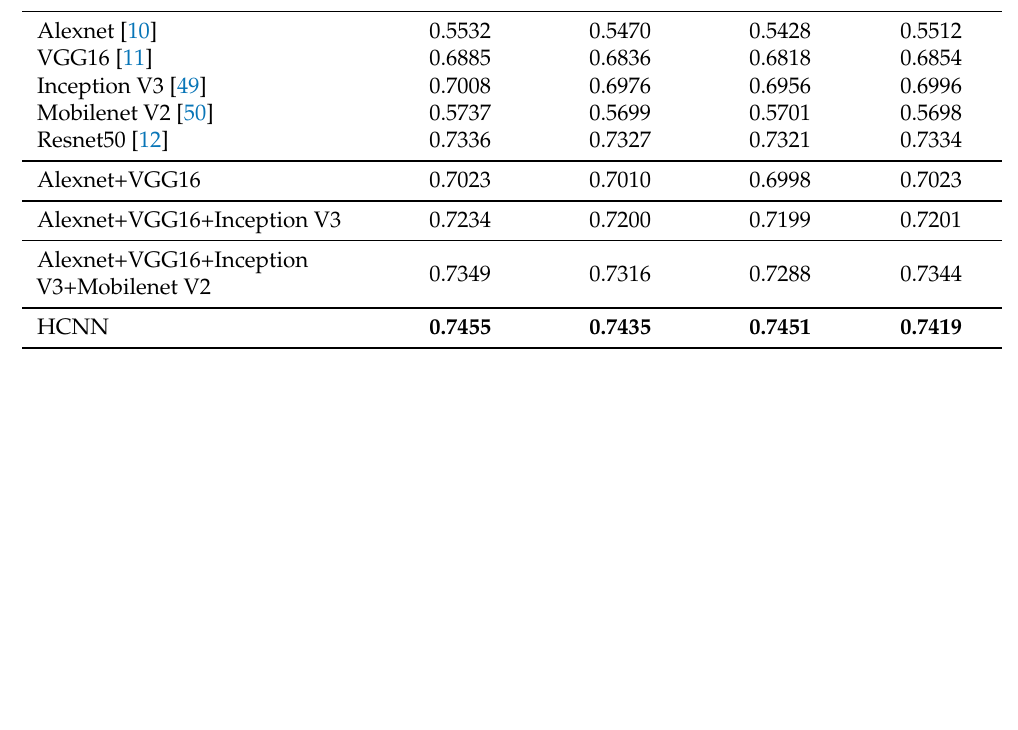
Table 3. The ablation analysis on the chimpanzee facial image dataset. Models